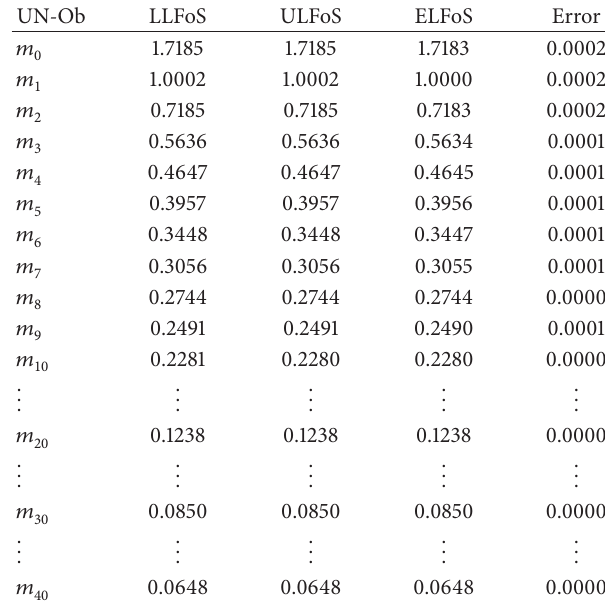
Table 3: Upper and lower bounds for Example 2 for 𝑁 = 50 . UN-Ob